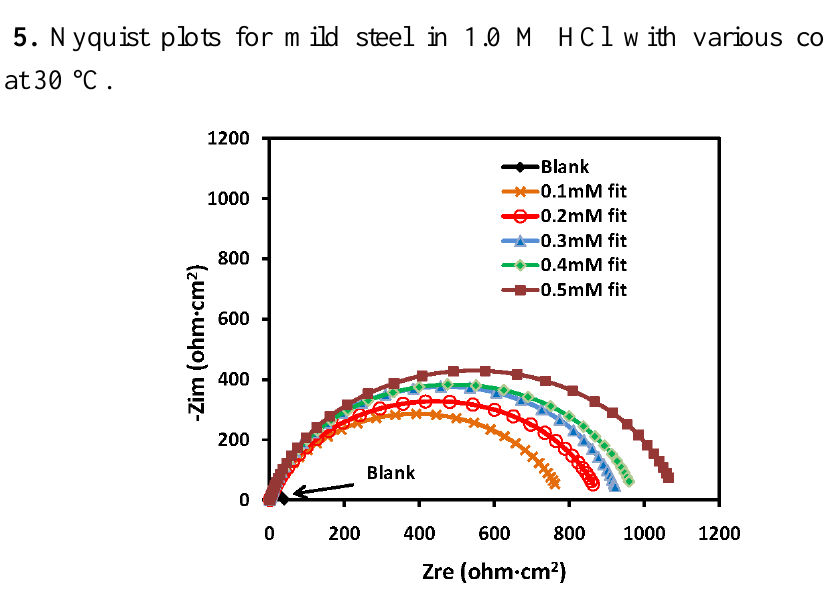
Figure 6. Nyquist plots for mild steel in 1.0 M HCl with 0.5 mM PMBH at various